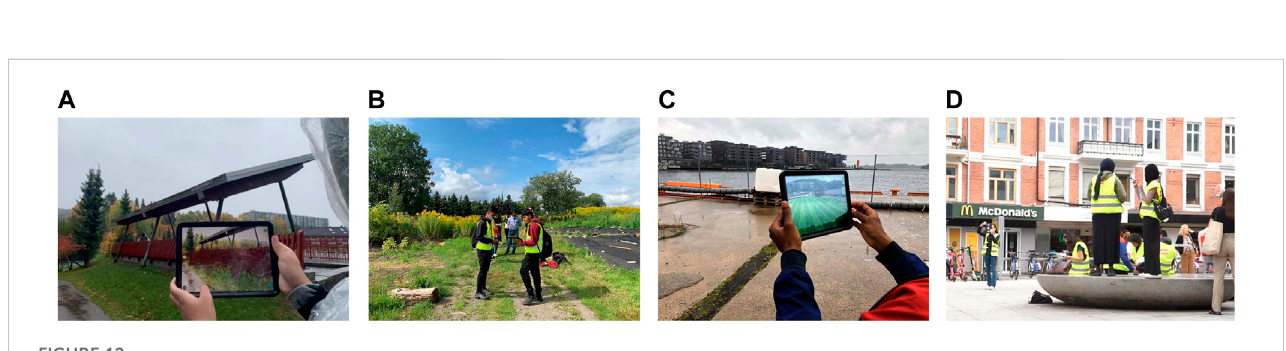
FIGURE 12 Panels (A – D) . Users placing trees in situ through